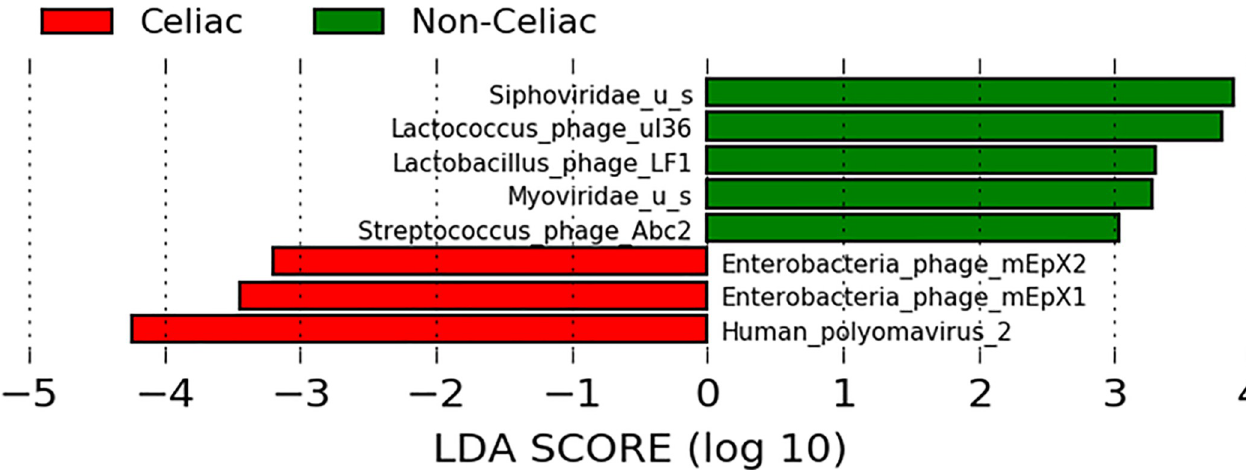
Fig 1. Effect size linear discriminant analysis (LDA) abundance in fecal samples. Bars with positive LDA scores are significantly higher in non-CeD samples (i.e., lower in CeD samples), and bars with negative LDA scores are significantly higher in CeD samples. The figure shows significantly more abundant Enterobacteria phage mEpX1 , Enterobacteria phage mEpX1 , and Human Polyomavirus 2 species in CeD samples and more abundant Lactococcus phage ul36 , Lactobacillus_phage Lf1 , and Streptococcus phage Abc2 species in non-CeD (less abundant in CeD) samples.